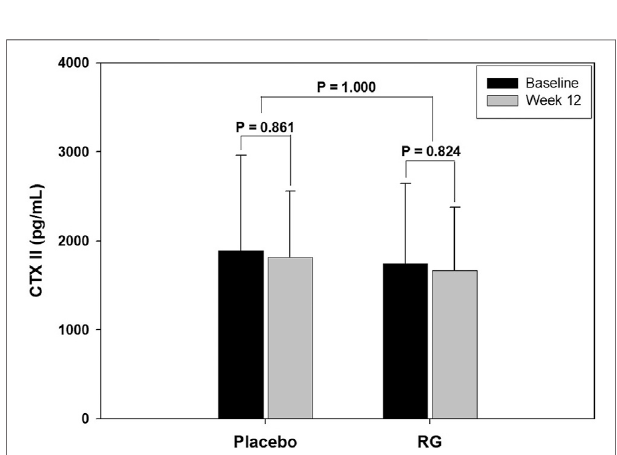
FIGURE 2 | Change in cartilage oligomeric matrix protein (COMP) level after 12 weeks of treatment.